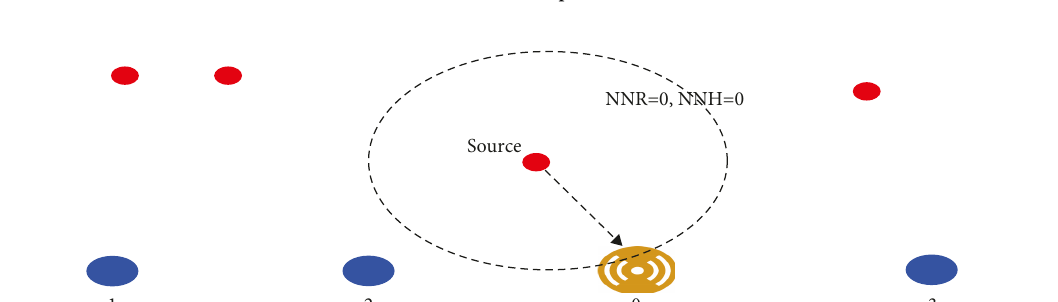
Figure 15: Selection of nanohop from the nanocluster.